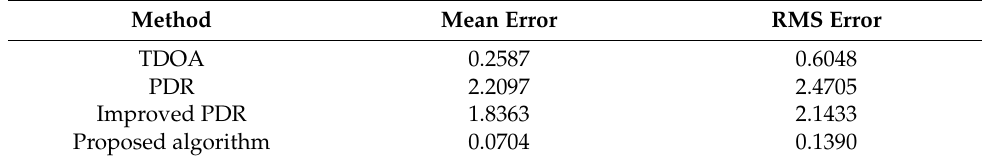
Table 2. Comparison of localization accuracy with different algorithms (m) (First scene).